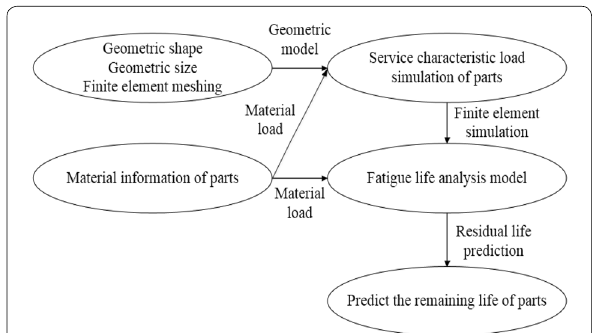
Figure 5 Finite element analysis process